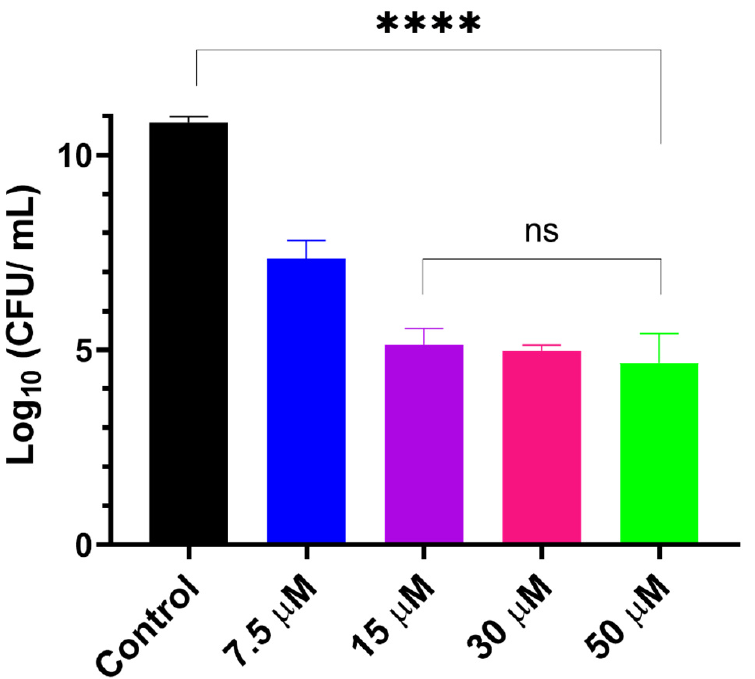
Figure 2. Viability of S. aureus biofilms following treatment with different concentrations of GaPP within LCNP, light dose 16 J/cm 2 . Data plotted as mean ± SD, n = 3. ns: non-significant, **** significant reduction in viability, p value < 0.0001 (one-way ANOVA test followed by multiple comparison Tukey’s test).